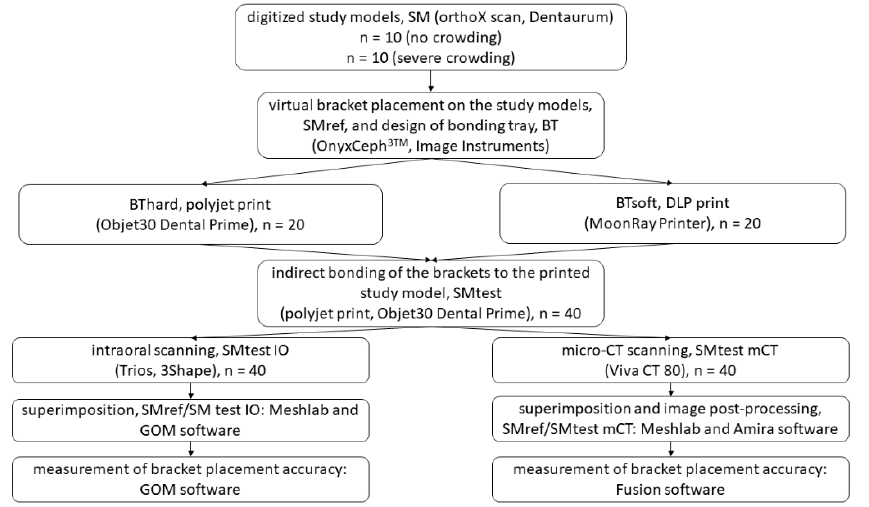
Figure 1. Flow diagram detailing the study workflow.